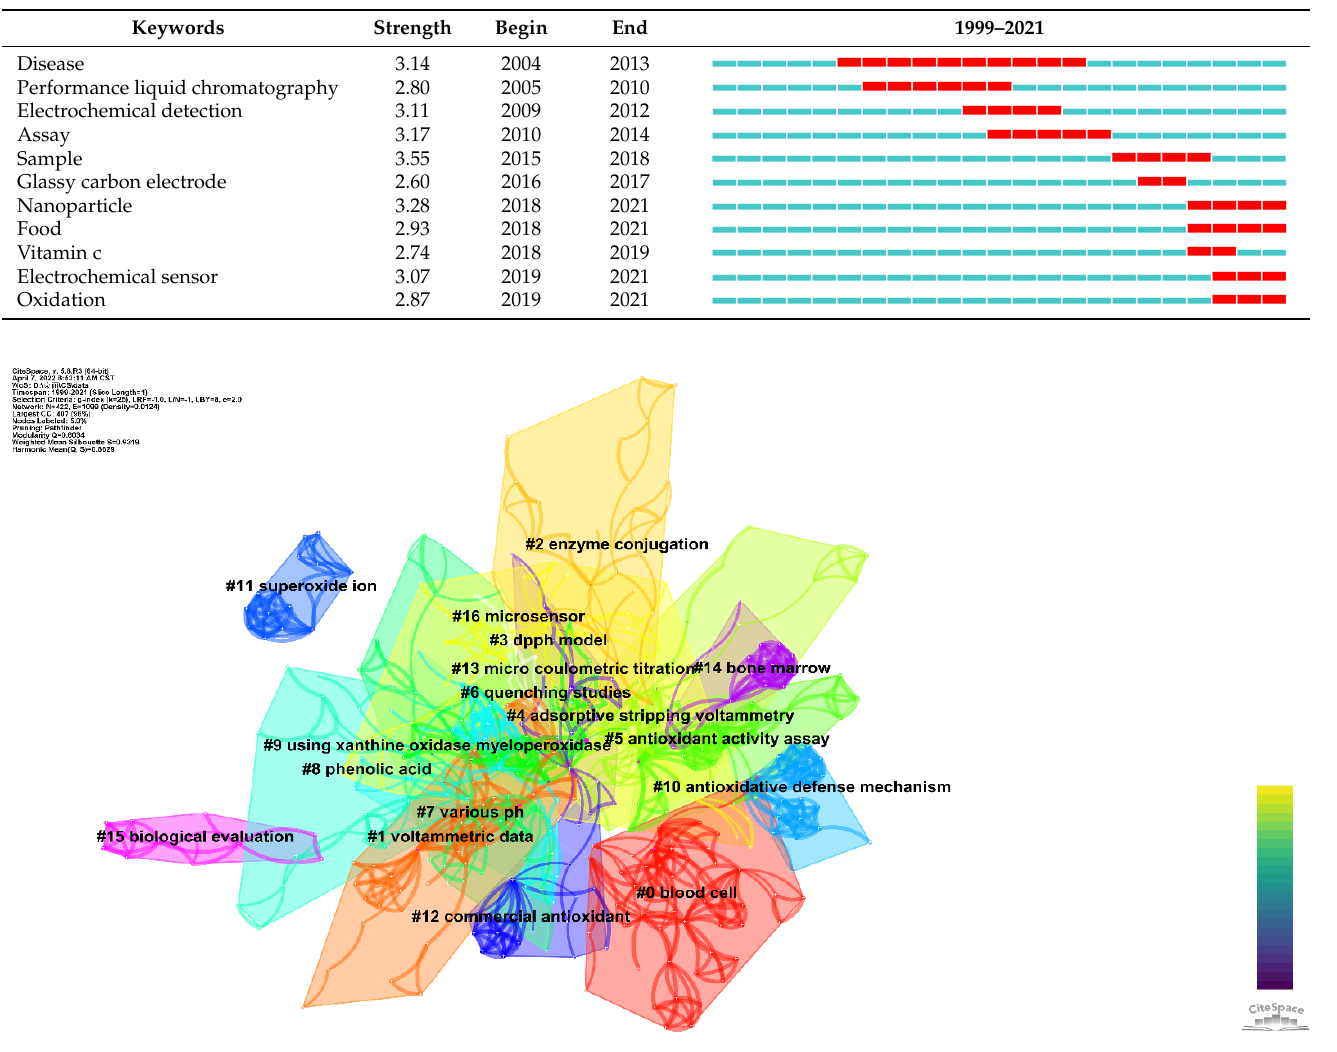
Figure 8. Grouping of keywords for the evaluation of antioxidants using electrochemical sensors.